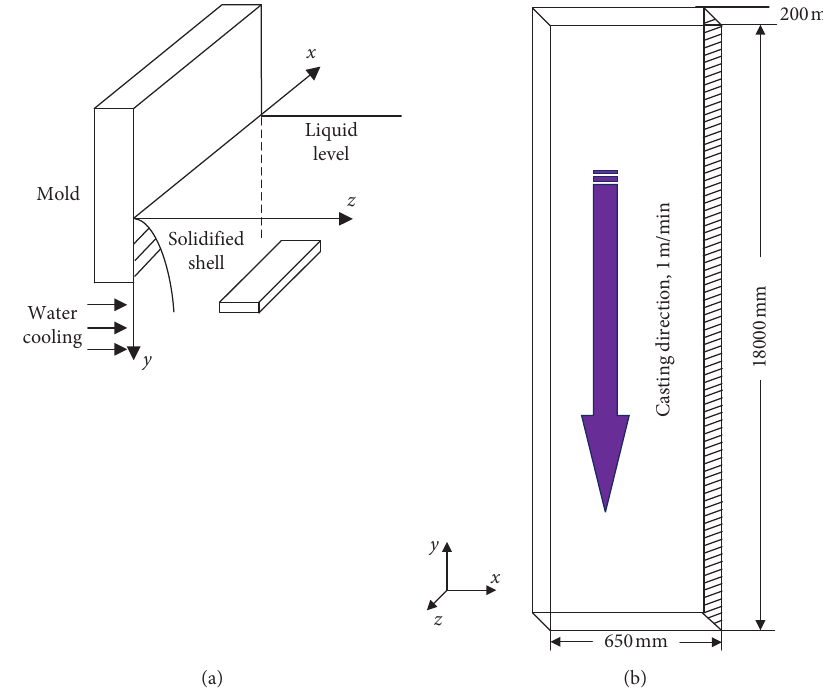
Figure 1: Schematic diagram: (a) simulated slice space coordinates; (b) geometry